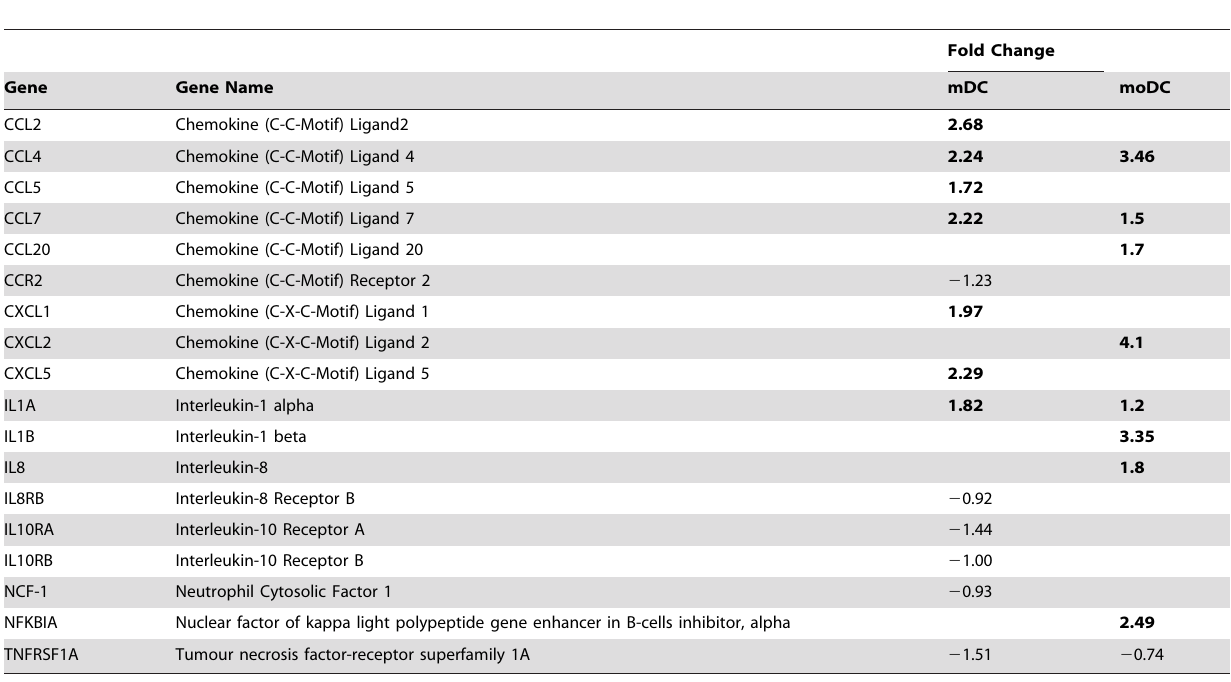
Table 3. Gene expression of immune-related genes in donor myeloid dendritic cells or monocyte-derived dendritic cells with the addition of A. fumigatus conidia (after 6 hours